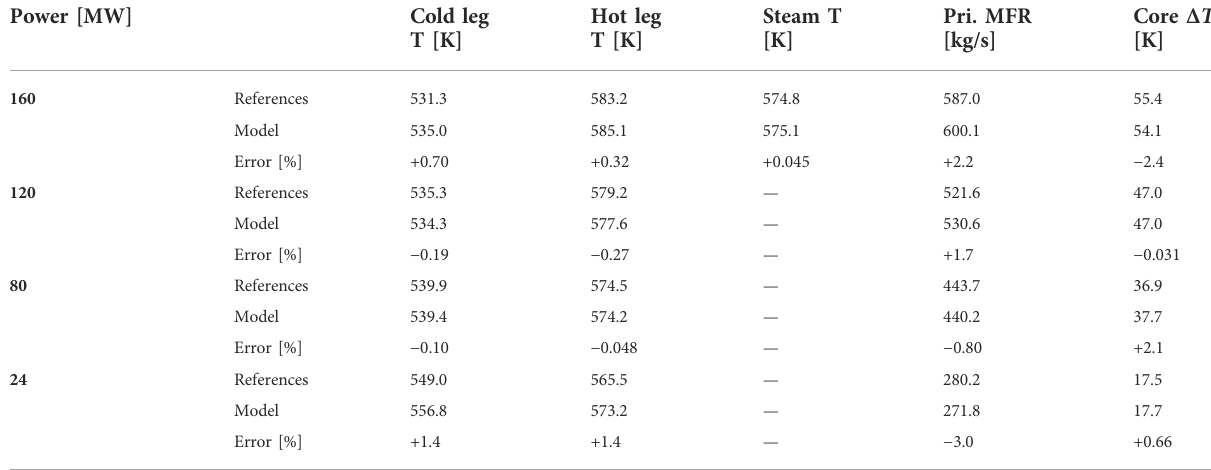
TABLE 3 Deviation of core inlet (cold leg), primary SG region inlet (hot leg) and secondary steam temperatures, primary coolant mass fl ow rate, and core inlet-outlet temperature difference from reference values at fourpower levels.Calculations are done in SI units, i.e., K for temperaturesand kg/s for